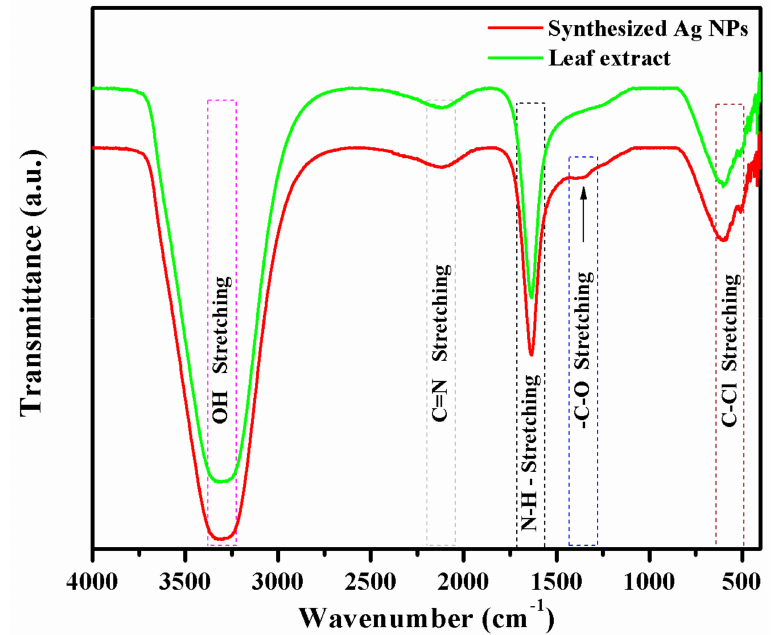
Figure 3. Fourier-transform infrared (FTIR) spectrum of leaf extract and synthesized Ag